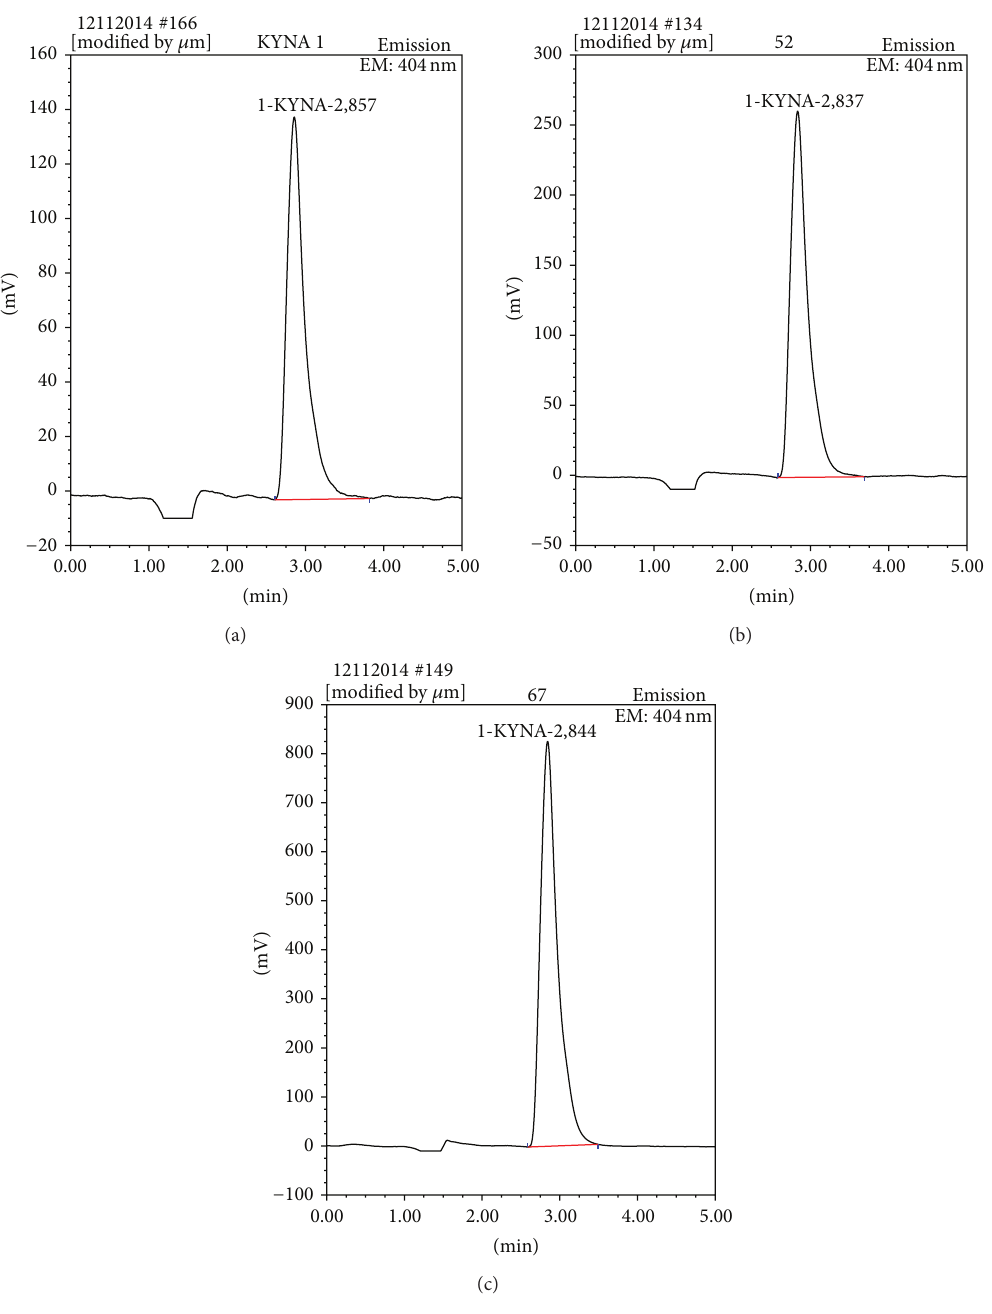
Figure 1: Overlay of samples from integration view. HPLC identification and quantification of KYNA in culinary herbs and spices: (a) authentic KYNA 1 pmol; (b) HPLC profile of a substance extracted from basil; and (c) HPLC profile of a substance extracted from thyme. Note identical retention time and shape of the